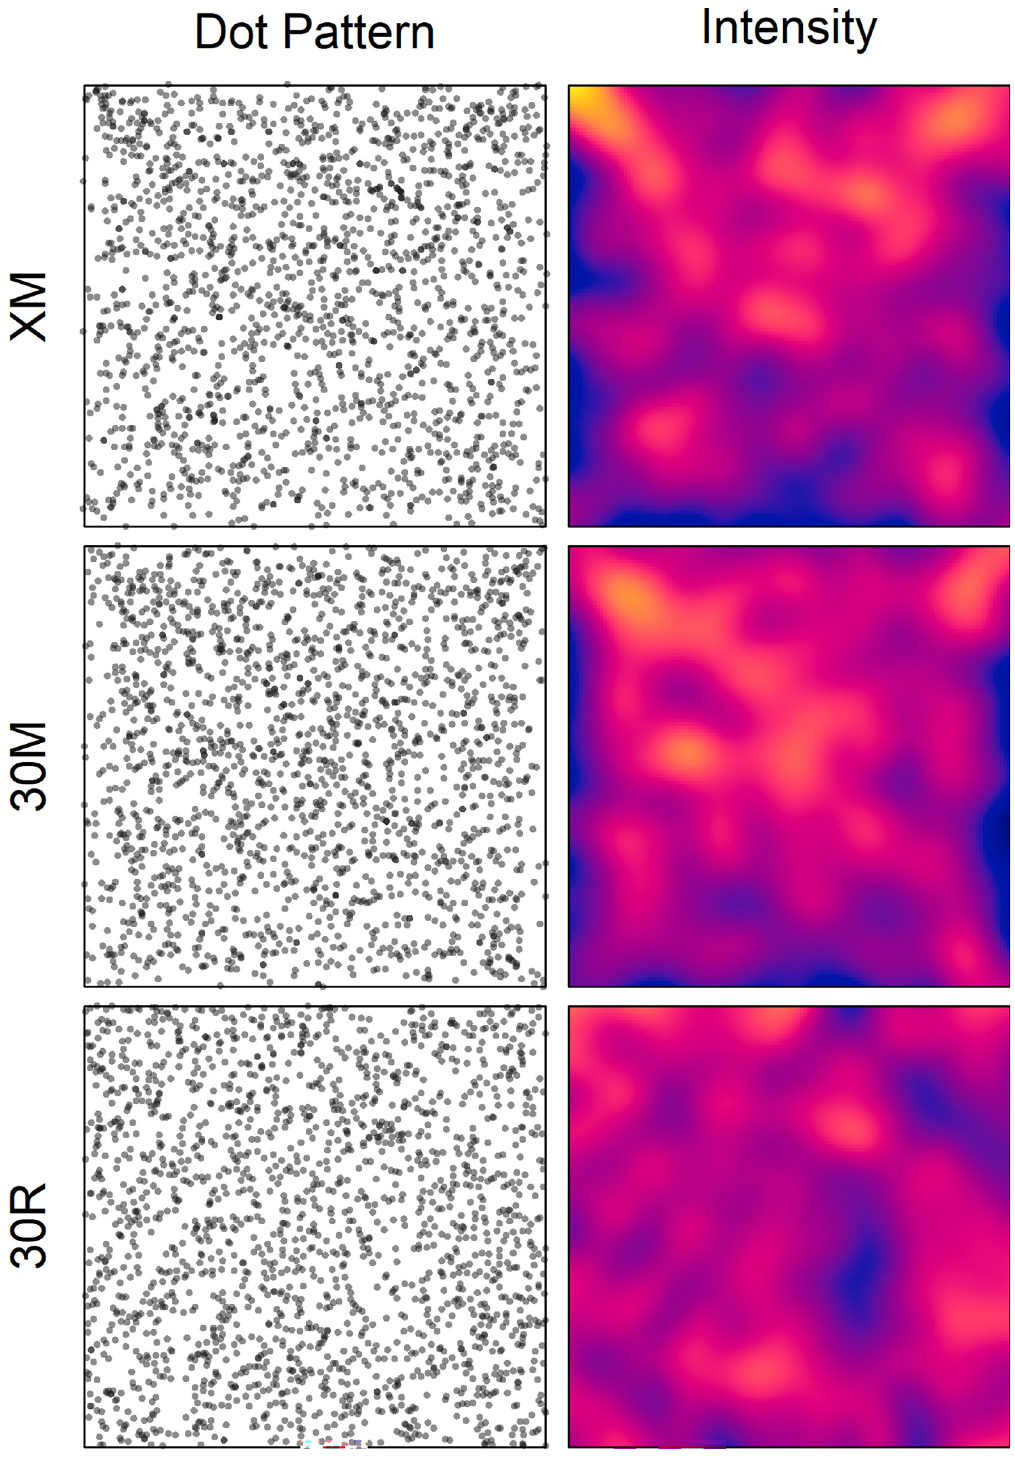
Fig 7. Patterns (column Dot Pattern) of superimposed individual dot patterns and corresponding intensity plots (column Intensity) for the two conditions in Experiment 2, and for a corresponding random-dot pattern (30R). The density ranges from 0.0048 (blue) to 0.0233